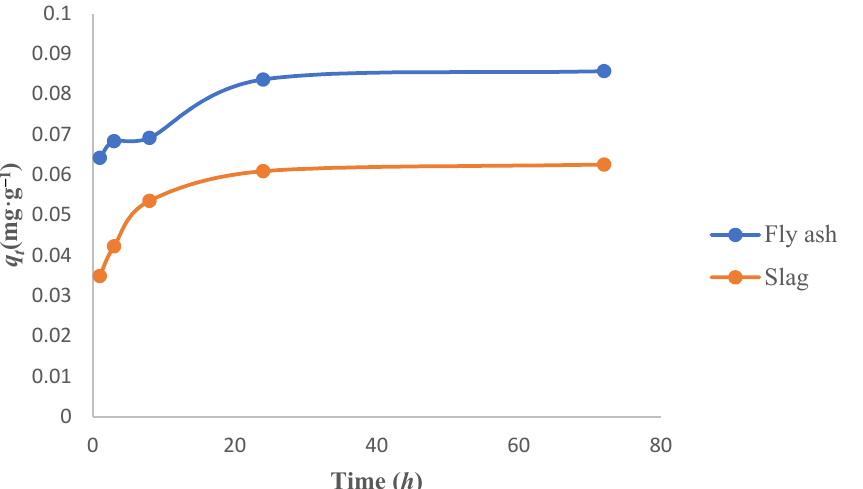
Figure 3. Adsorption capacity of fly ash-based geomaterials and slag-based geomaterials for Cs adsorption.